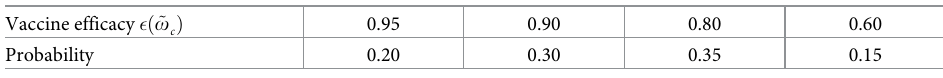
Þ ) used in this study. c